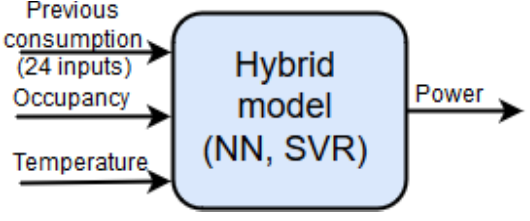
Figure 5. Hybrid model to predict the next day